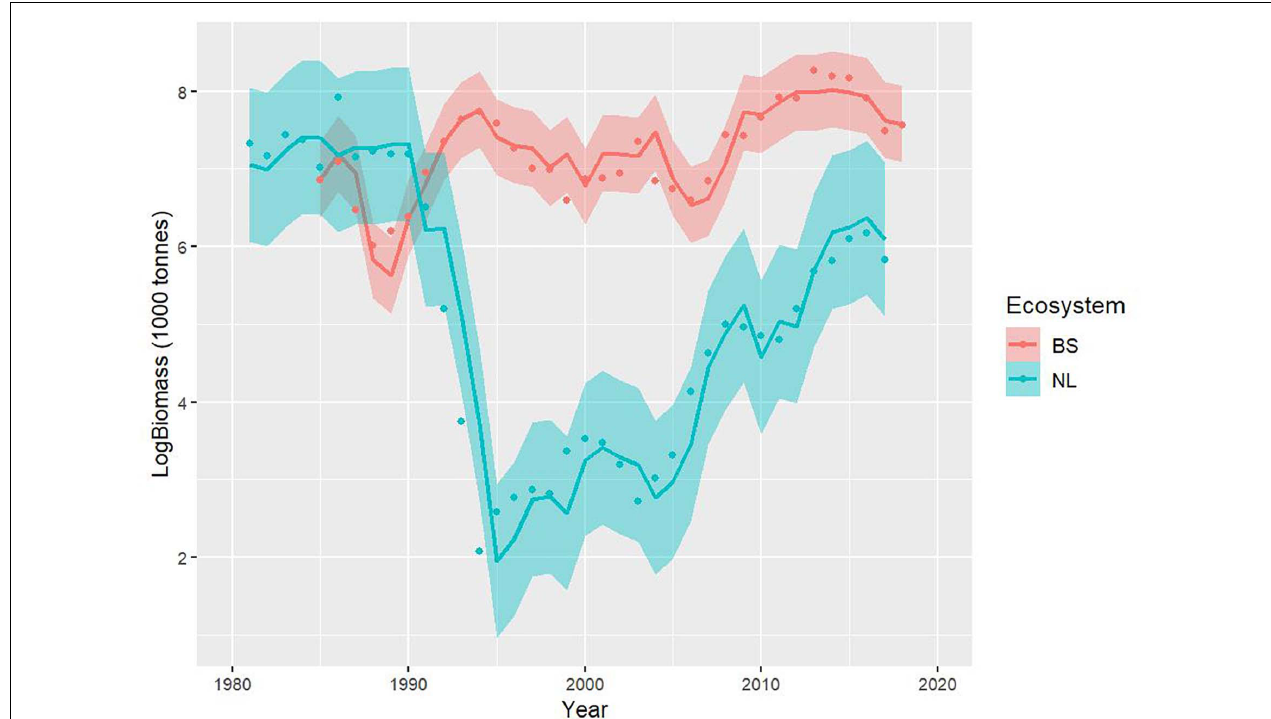
FIGURE 3 | Model fits (log scale) for the Newfoundland-Labrador shelves (NL) (blue line) and Barents Sea (BS) (red line) cod stocks and 95% confidence intervals (shaded areas). These fits correspond to fully independent stocks (i.e., no common parameters between stocks).